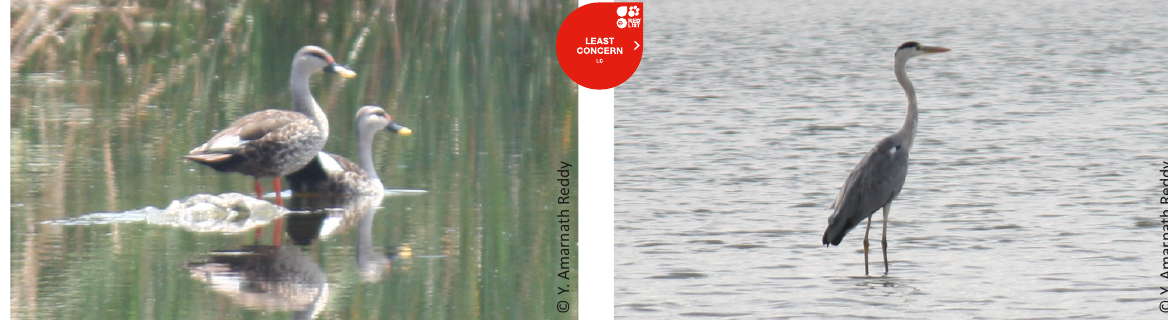
Image 1. Anas poecilorhyncha Spot-billed Duck